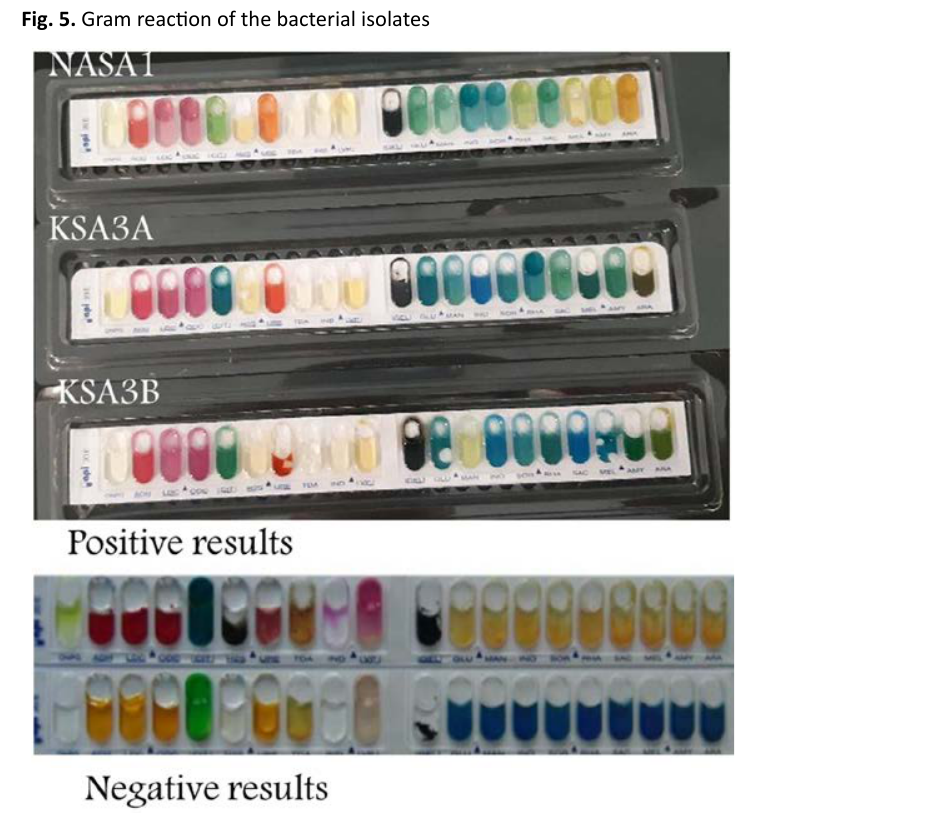
Fig. 6. Results of the API 20 NE kit for the three bacterial isolates. Positive and negative controls are also presented for